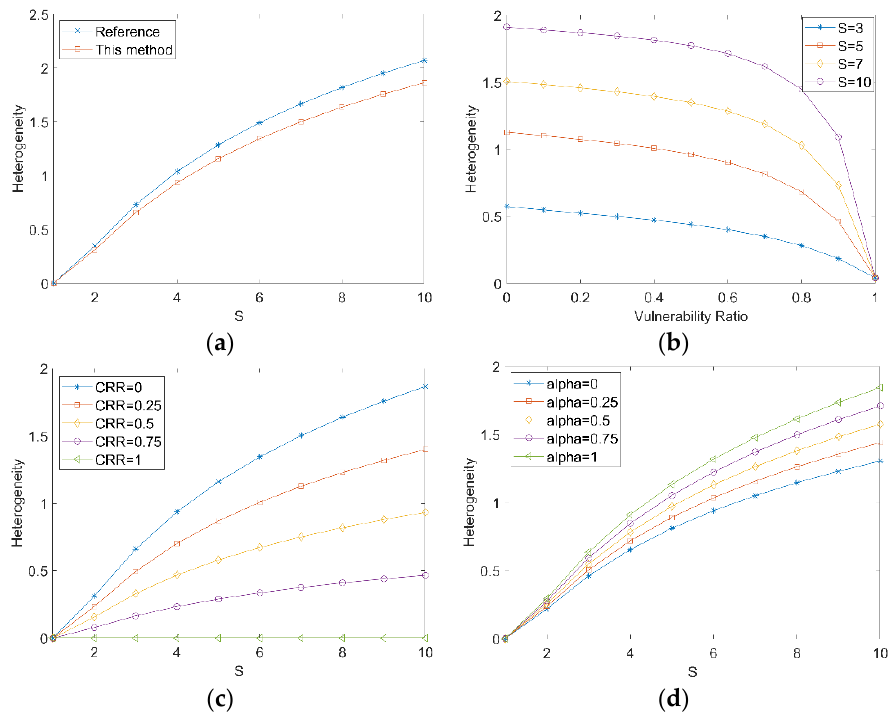
Figure 6. HET1 of the mimic control plane. ( a ) Comparison of HET1 and HBCV; ( b )The impact of symbiotic vulnerability ratio; ( c ) The impact of the number of executors; ( d ) The impact of the vulnerability discovery coefficient.